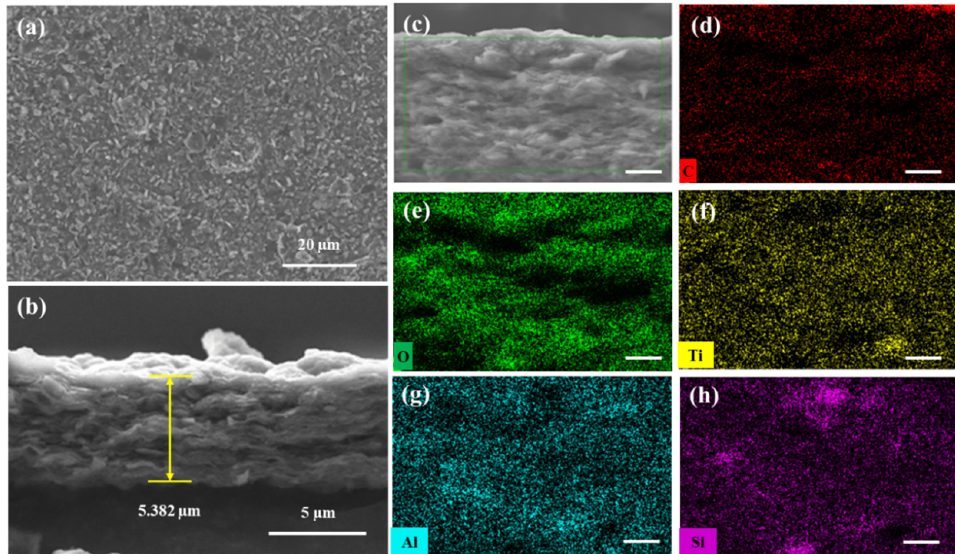
Figure 4. SEM images of the MXene/attapulgite (1:2) composite membrane: ( a ) top view and ( b ) cross-sectional view (magnified in ( c )). Element distribution results of the MXene/attapulgite composite membrane (mapping from ( c )) regarding different elements: ( d ) C, ( e ) O, ( f ) Ti, ( g ) Al, and ( h ) Si, scale bar: 1 µ m.